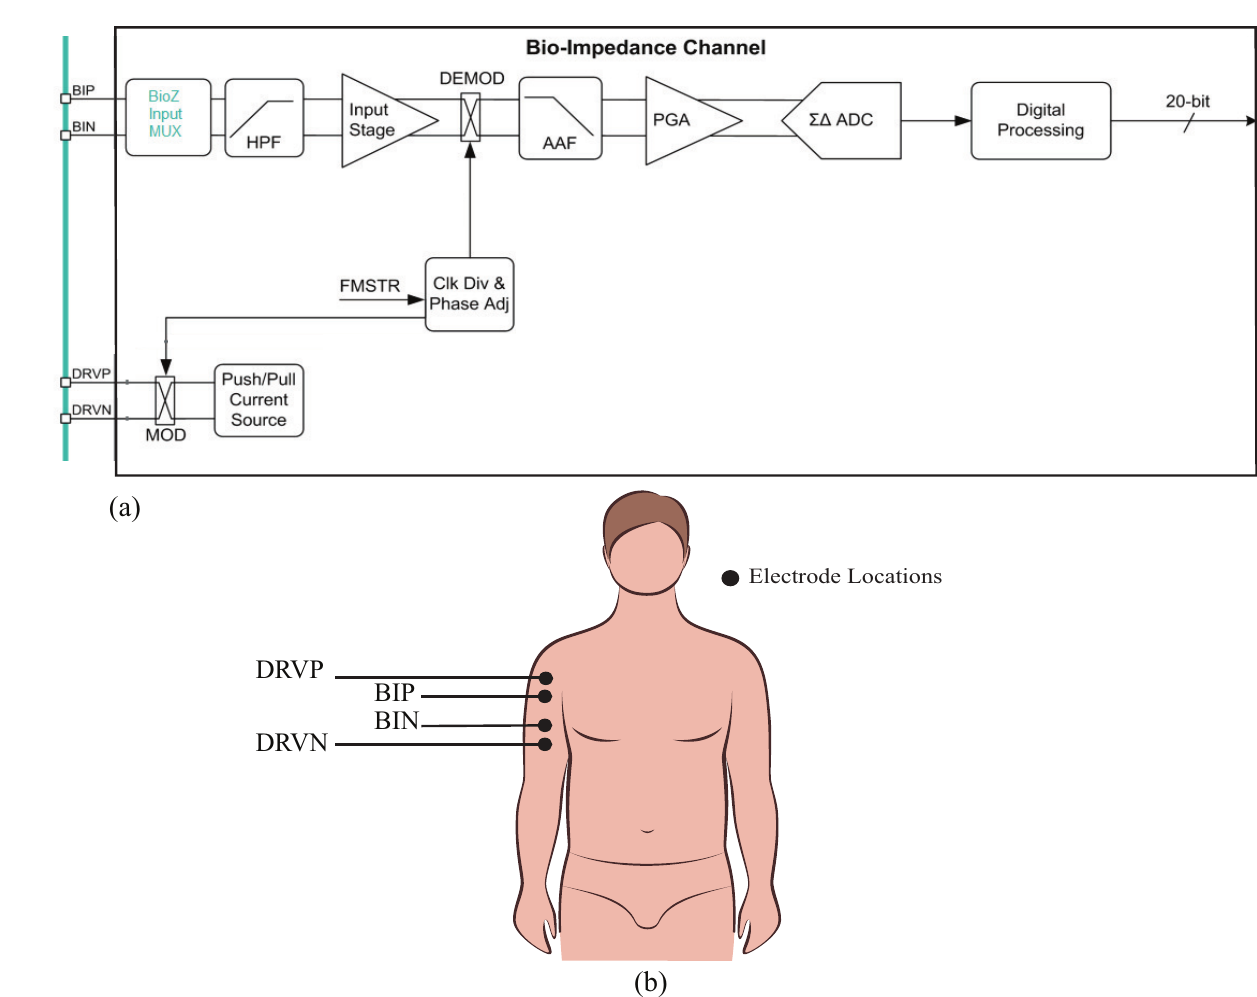
Figure 1. ( a ) MAX3000x bioimpedance channel outlining the high-level signal conditioning applied to the signal measured at the voltage sensing pins (BIP, BIN) and ( b ) sample tetrapolar interface of the MAX3000x bioimpedance pins (DRVP, DRVN) with a localized bicep